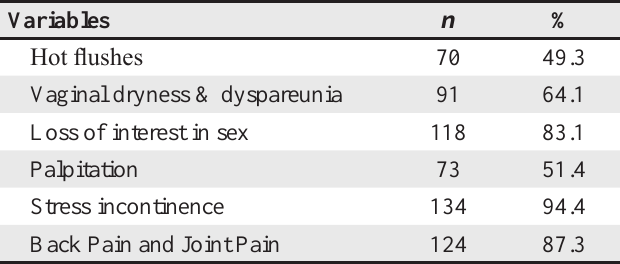
Table 3 : Respondents' knowledge on physical sign and symptoms of perimenopause Variables